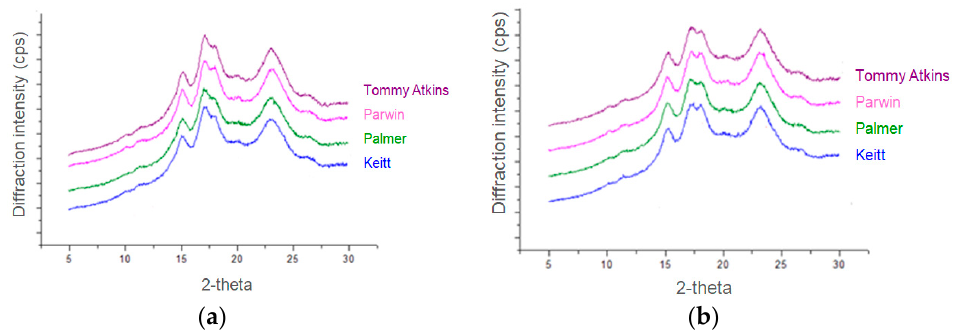
Figure 2. X-ray diffraction patterns of isolated starches granules from mango fruits. Pulp starches ( a ), Kernel starches ( b ).